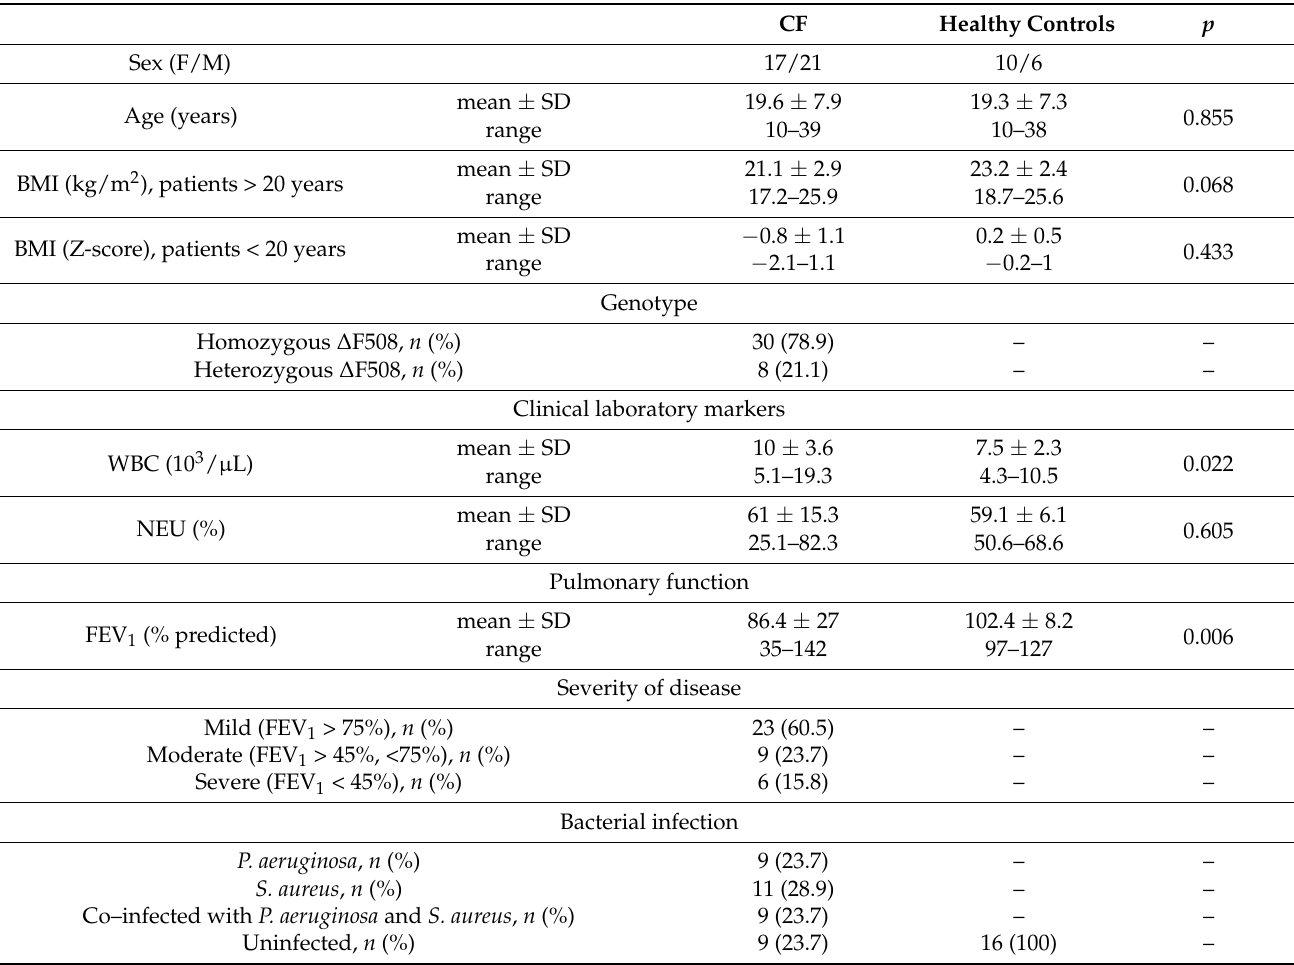
Table 1. Basic clinical parameters of study participants